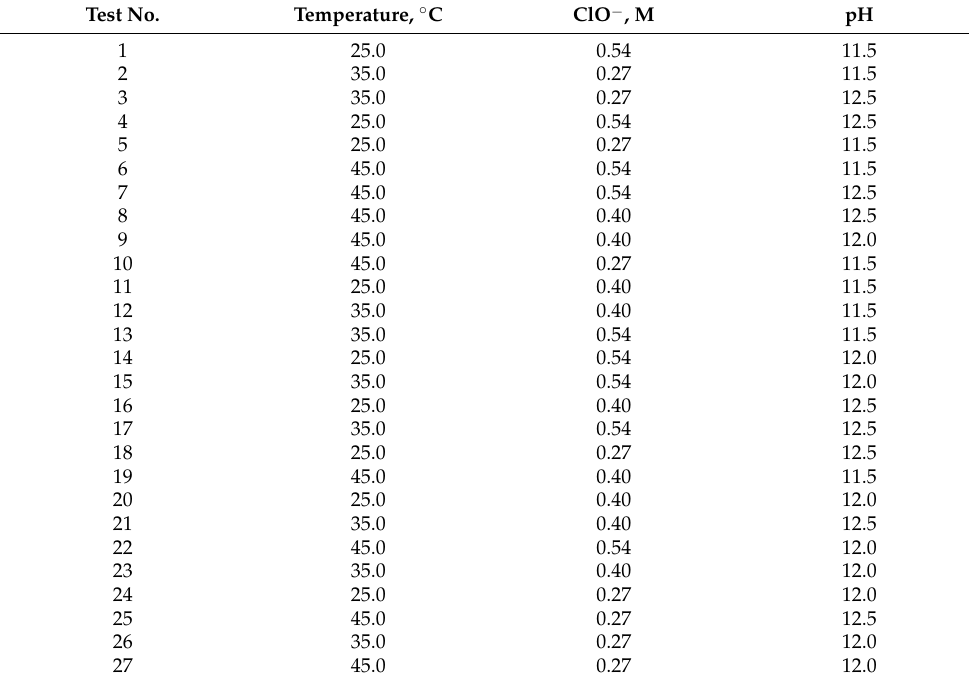
Table 3. Experimental model to evaluate the reaction progress, L 27 (effects).